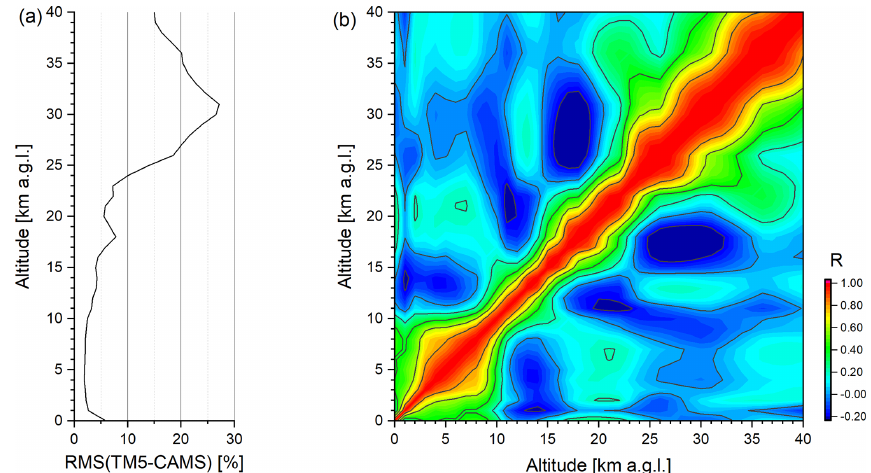
Figure F1. Comparison of the CH 4 state obtained from the TROPOMI a priori model TM5 ( x TM5 ) and the collocated CAMS high-resolution forecasts ( x CAMS ). (a) The rms of the relative differences; (b) Matrix showing the correlations of TM5-CAMS differences at different altitudes.